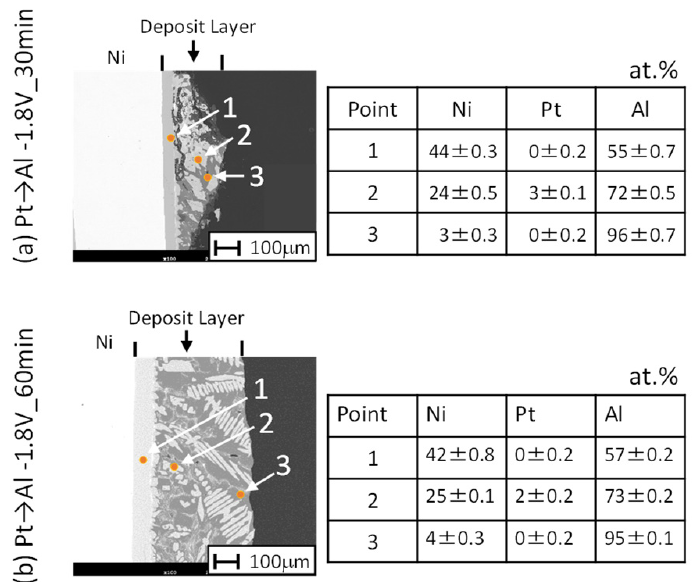
Figure 5. Cross-sectional microstructure and point analysis results of Al electrodeposition-treated sample at − 1.8V after Pt electrodeposition.